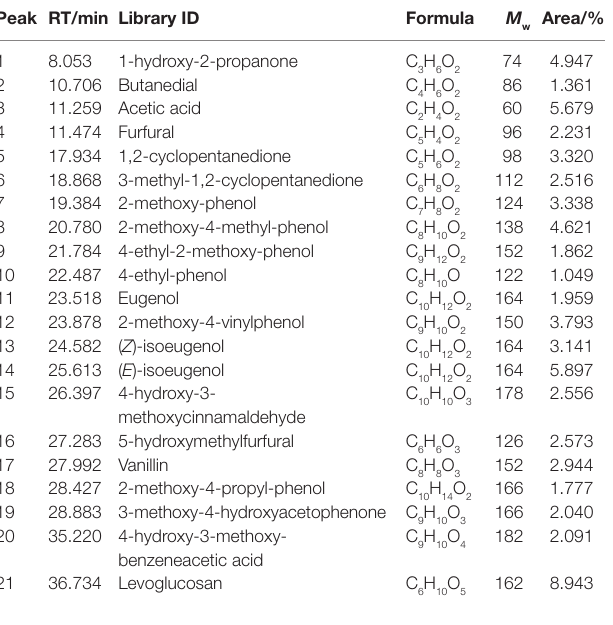
TaBle 2 | identification of the main components (peak area > 1%).